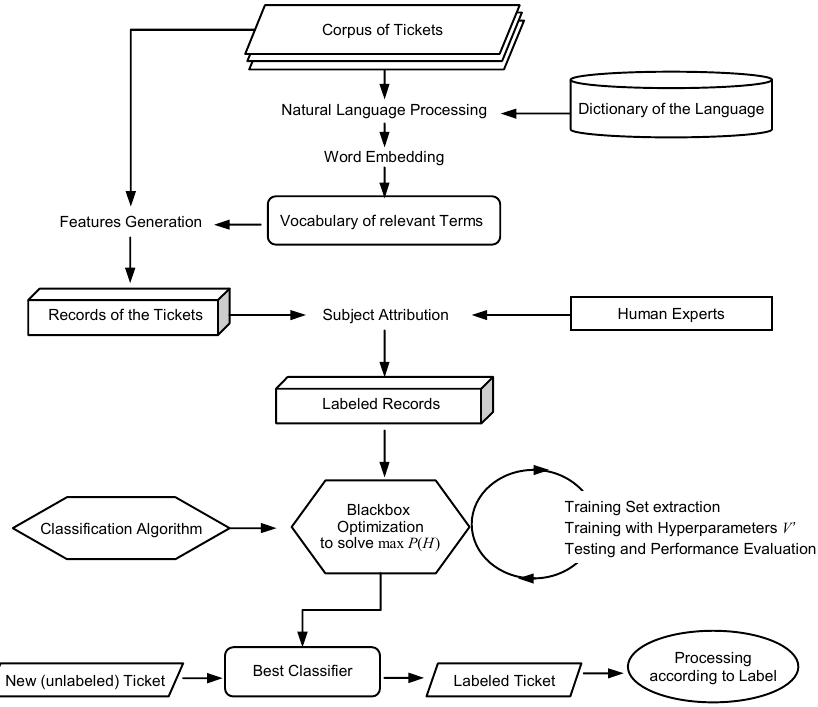
Figure 1: Overall scheme of the proposed approach, including both the text mining phase and classification phase with hyperparameters the classification phase with hyperparameters optimization.